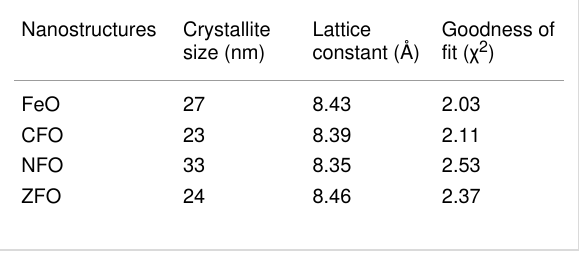
Table 1: Different physical parameters calculated from XRD